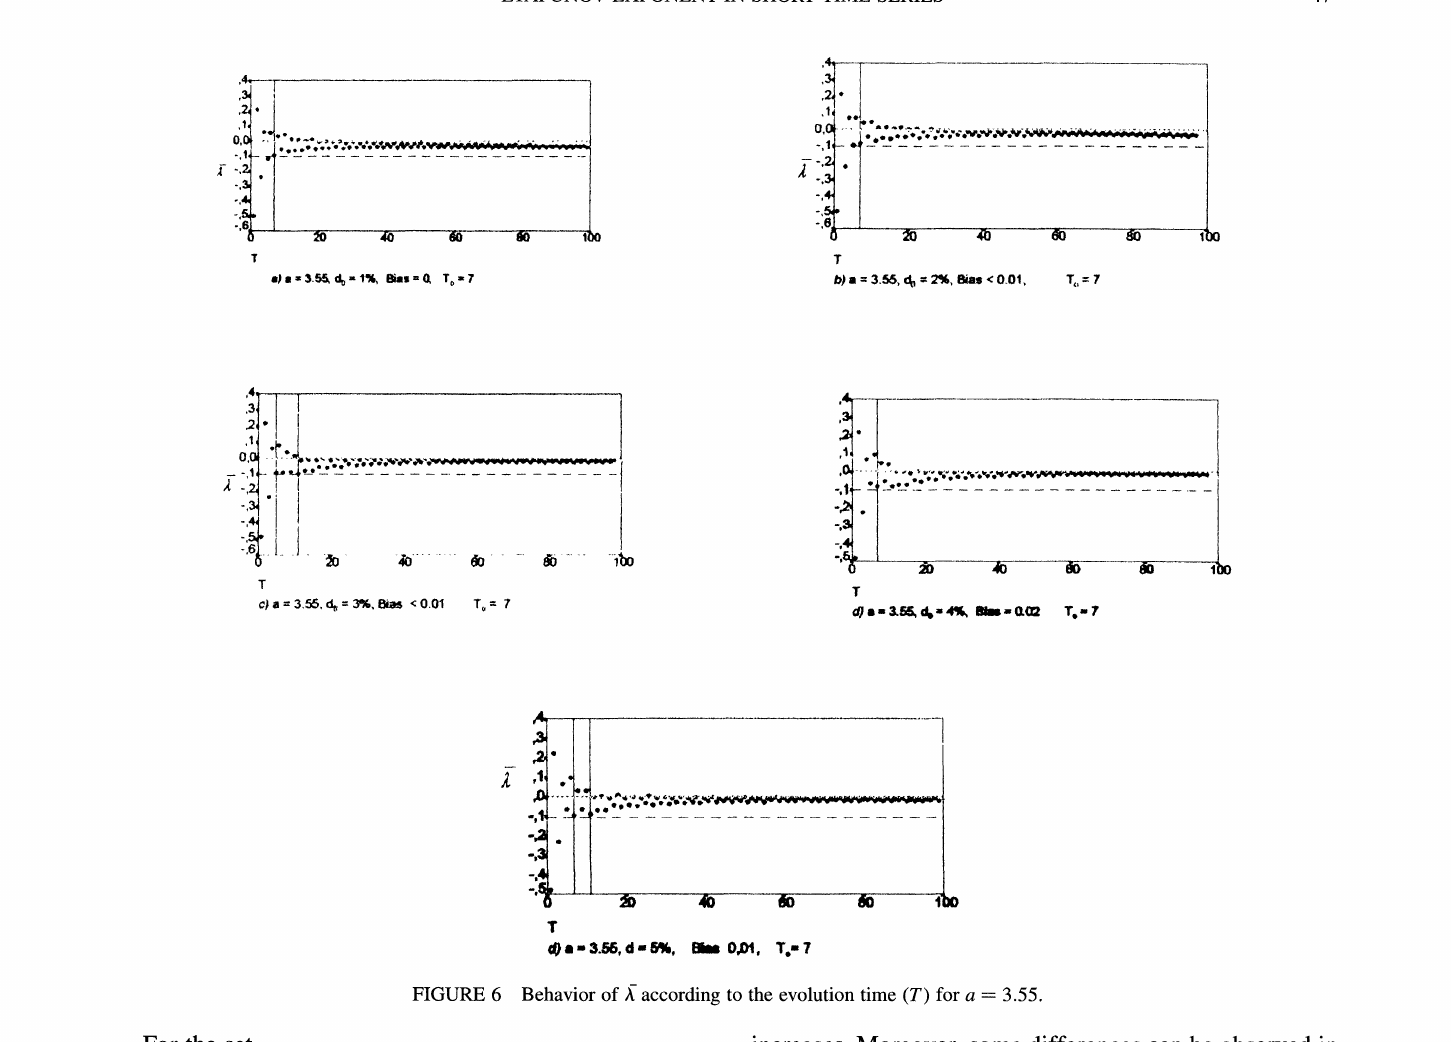
FIGURE 6 Behavior of X according to the evolution time (T) for a